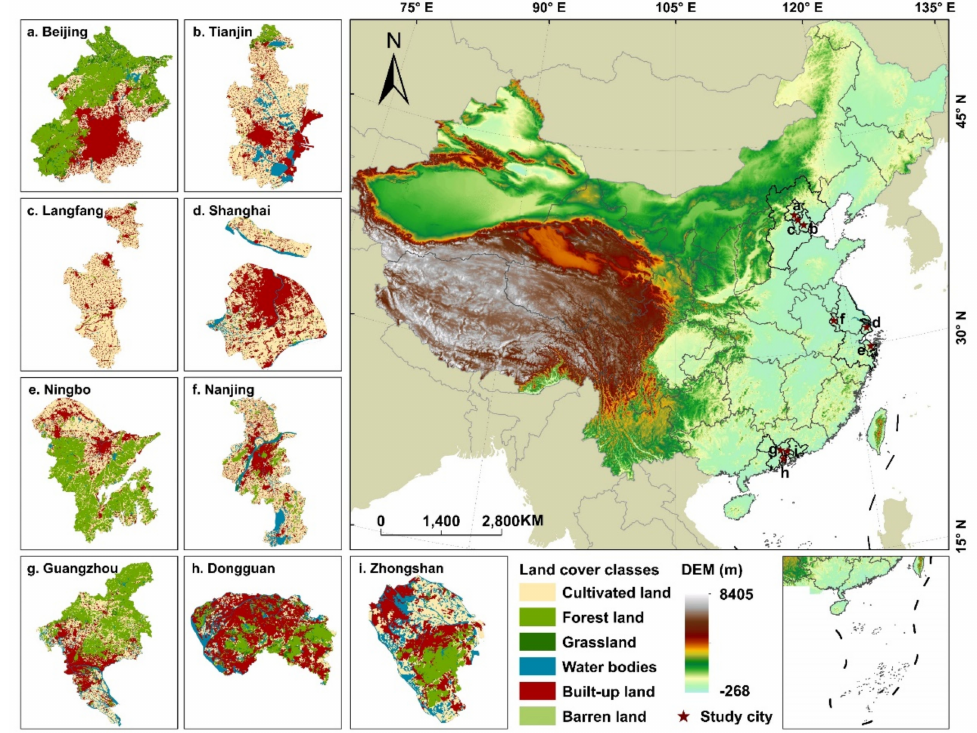
Figure 1. Locations of the study regions: ( a ) Beijing; ( b ) Tianjin; ( c ) Langfang; ( d ) Shanghai; ( e ) Ningbo; ( f ) Nanjing; ( g ) Guangzhou; ( h ) Dongguan; ( i ) Zhongshan. The land cover